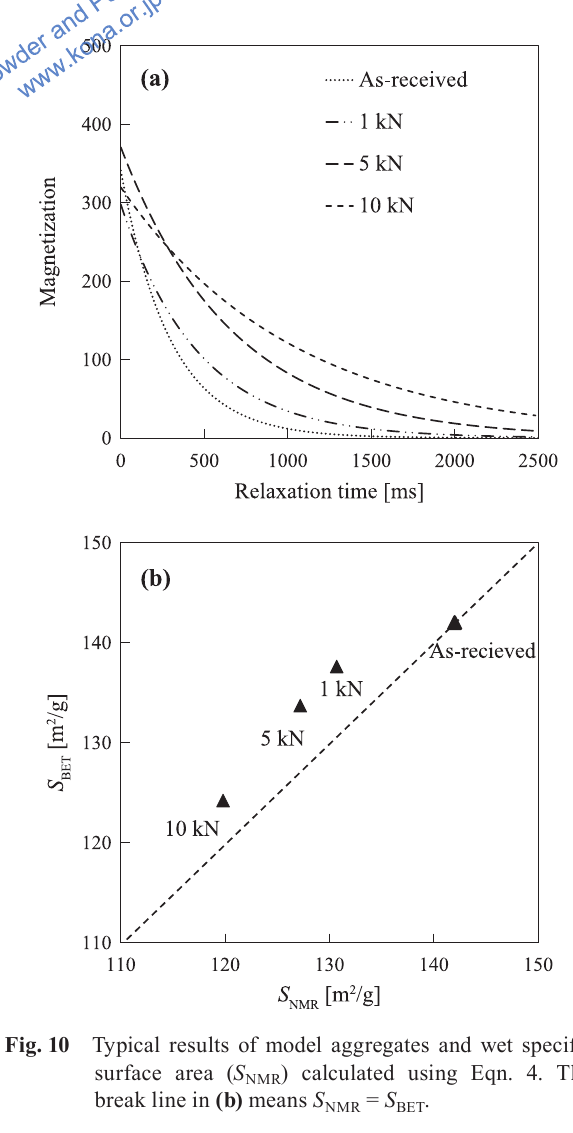
Fig. 10 Typical results of model aggregates and wet specific surface area ( S NMR ) calculated using Eqn. 4. The break line in (b) means S NMR = S BET